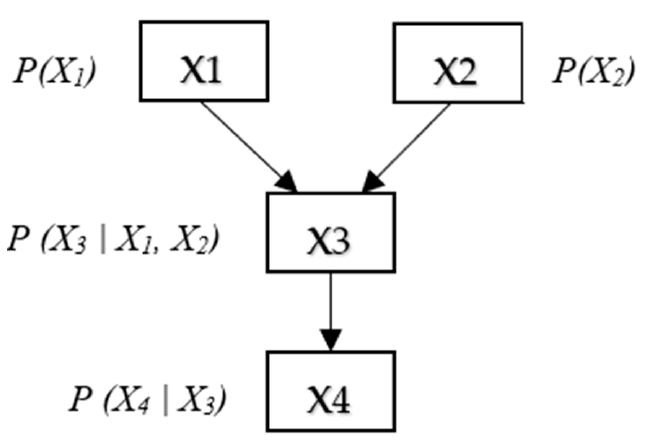
Figure 3. An example of a BN with four variables.